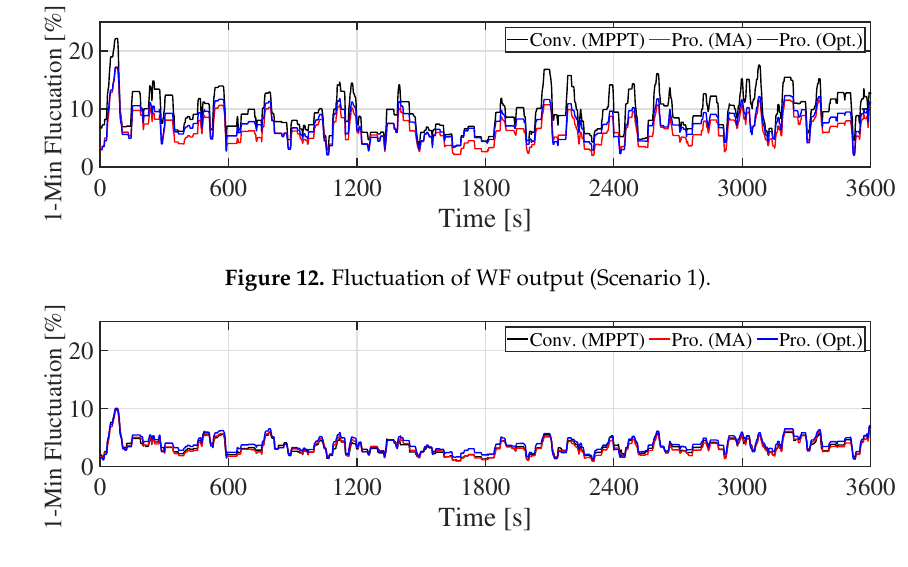
Figure 13. Fluctuation of combined output (Scenario 1).